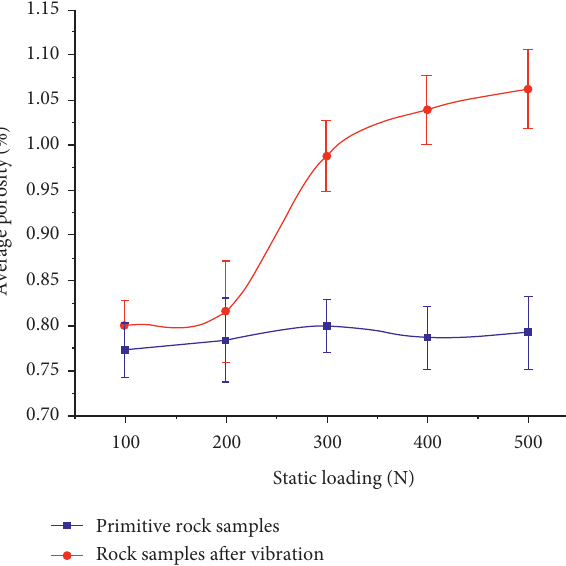
Figure 9: Temperature curves of fixed monitoring points of rock. Figure 10: Porosity curve of samples with static